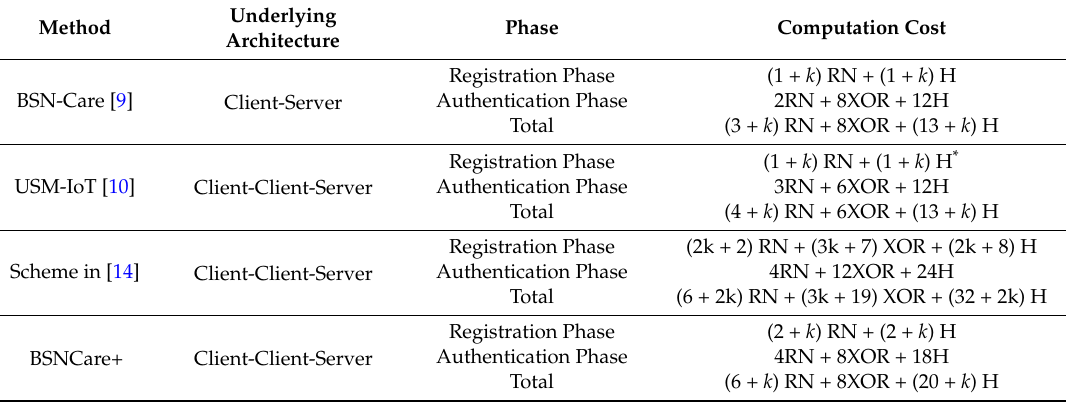
Table 7. Performance comparison among BSN-Care [9], USM-IoT [10], scheme in [14] and BSNCare+ 1